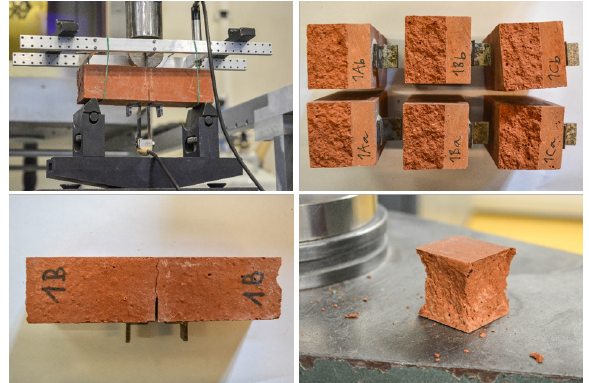
Figure 2. TORATOM tomography system: Active damped anti-vibration table with high-precision CNC positioning system (1) holds two imaging pairs of the X-ray tube (2, 3) and detector (4, 5) in an orthogonal arrangement with shared rotary stage (6) accommo- dating the investigated